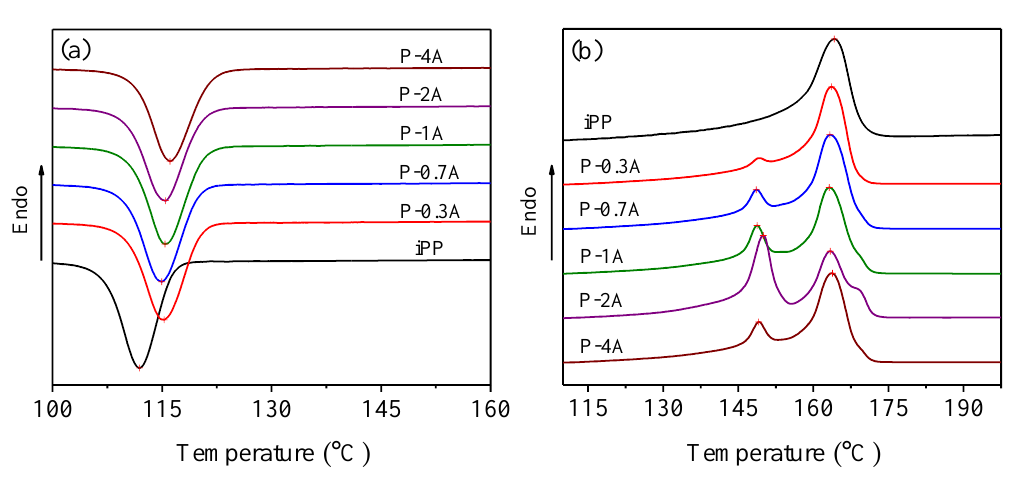
Figure 5. DSC curves of pure iPP and iPP/ABS blends on the first cooling ( a ) and the second heating scan ( b ). Table 1. Crystallization and melting parameters of pure iPP and iPP/ABS blends.